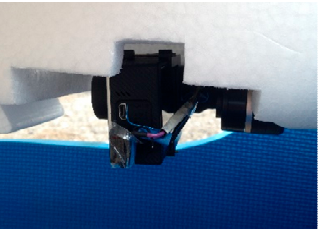
Figure 4. GoPro HERO 4 attached to the camera gimbal.